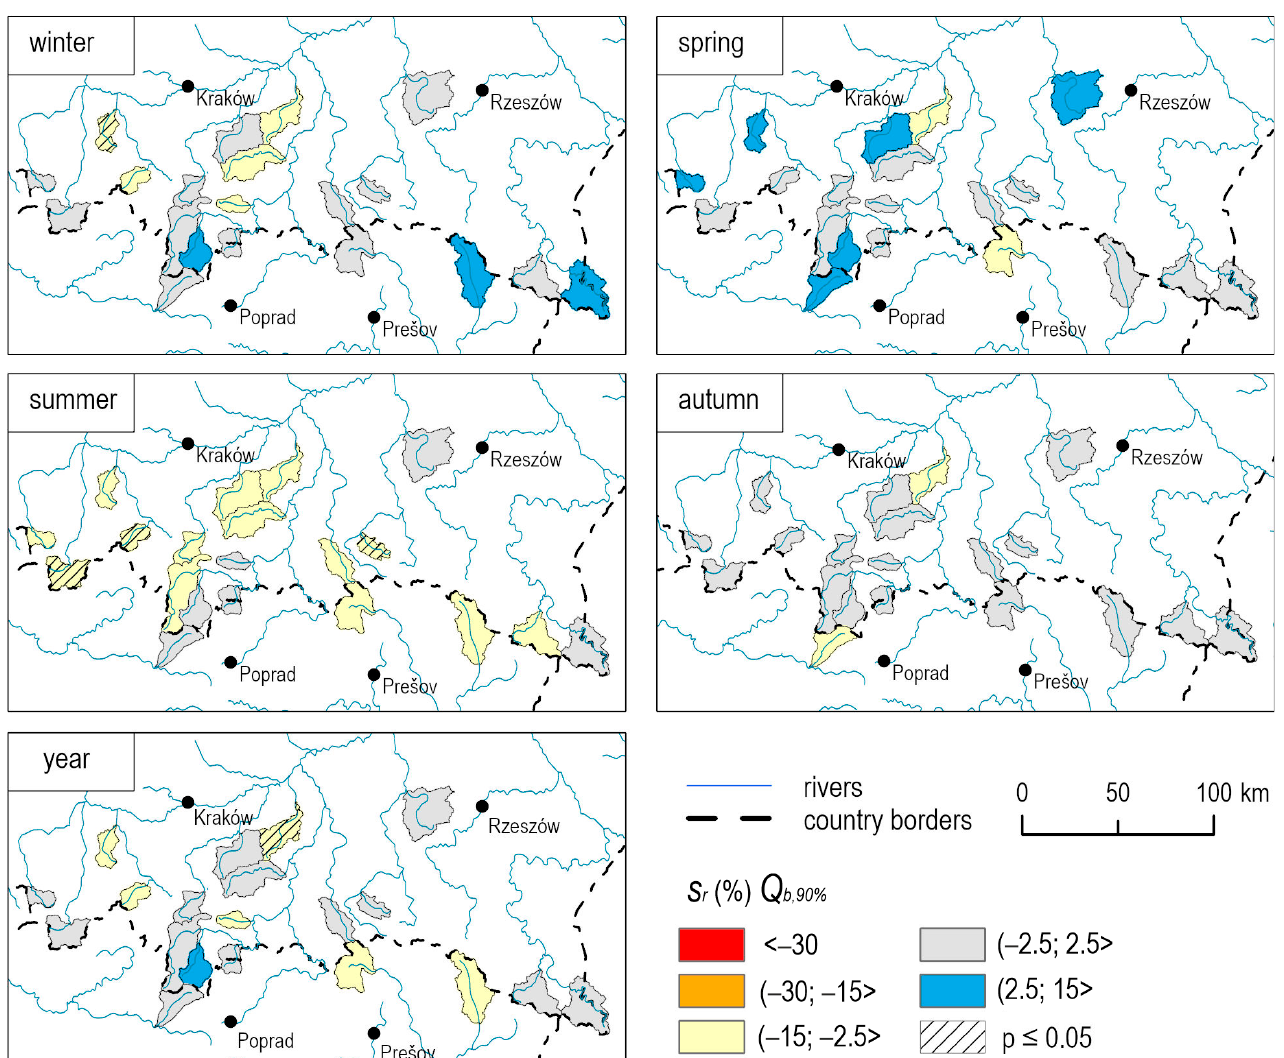
Figure 7. Relative changes in high baseflow values ( Q b, 90% ) in the years 1970–2019. The comparison of the relative values of the Sen’s slope estimator calculated for high mountains ( n = 3), medium mountains ( n = 13), and foothill catchments ( n = 4) indicated that changes in the baseflow differed among the altitudinal zones (Figure 8). In the winter and spring half-year in the high-mountain catchments, there was a common tendency of an increasing baseflow, visible especially in the case of percentiles representing the lowest values of runoff. In the same period, foothill catchments revealed tendencies of a decreasing baseflow. Changes in the middle mountains are ambiguous—the trend values are close to zero. On the other hand, in the summer and autumn half-year, negative trends prevailed in all catchments; however, in foothill catchments, they were the most evident. The occurring changes were best noticeable on the percentile values representing the lowest values of the baseflow.